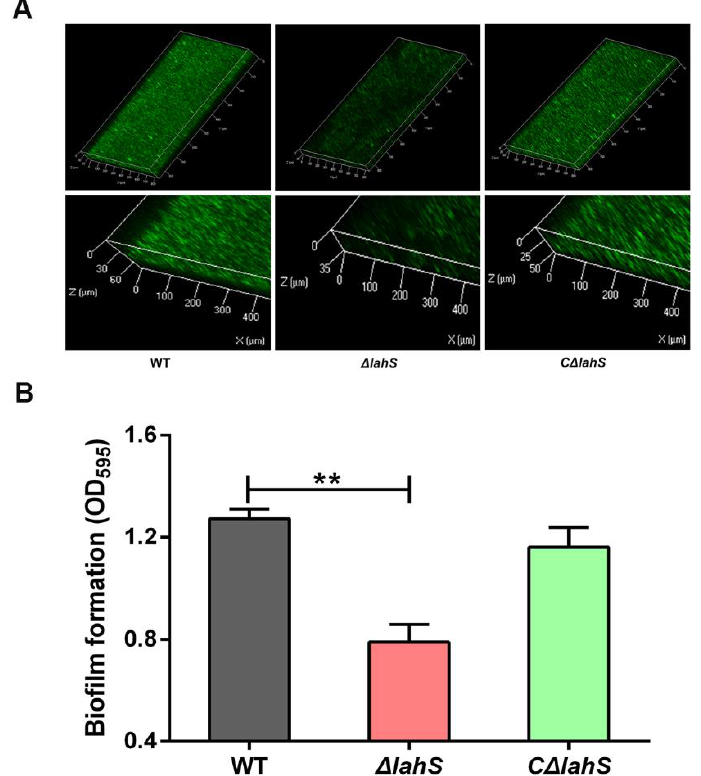
Figure 4. Biofilm formation of the wild-type and lahS mutant strains. ( A ) CLSM images of biofilms of the wild-type and lahS mutant strains. The viable cells exhibit green fluorescence. ( B ) Biofilm formation was measured by crystal violet staining using 96-well plates and was expressed as the values measured at OD 595 . The data are presented as the means ± SEM from three independent experiments. ** p < 0.01.